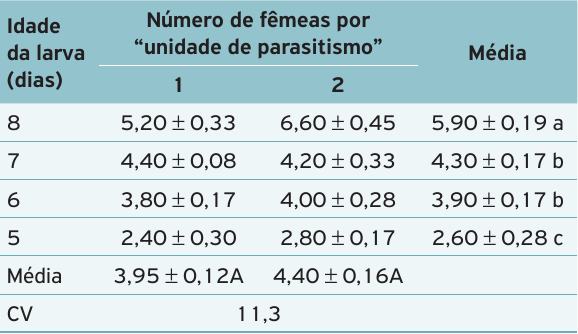
Tabela 3. Médias ( ± Erro Padrão) da longevidade (em jejum) de fêmeas de Diachasmimorpha longicaudata obtidas de larvas de Ceratitis capitata de diferentes idades. Temperatura 26 ± 1ºC; UR 65 ± 10% e fotofase 14